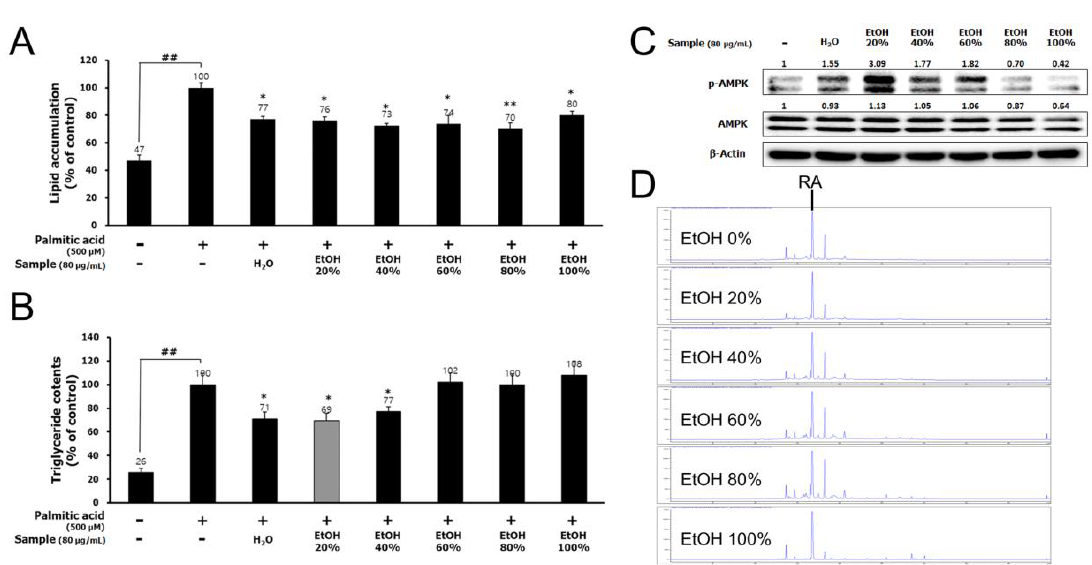
Figure 1. Effects of lemon balm extracts (0%, 20%, 40%, 60%, 80%, or 100% EtOH) on ( A ) lipid accumulation by Oil red-O staining and ( B ) triglyceride (TG) contents in palmitic acid (PA)-treated HepG2 cells. Effects of lemon balm extracts on ( C ) phosphorylation of AMP-activated protein kinase (AMPK) in HepG2 cells. ( D ) The rosmarinic acid (RA) content in the lemon balm extracts by liquid chromatograph. Results are expressed as the mean ± SD of three independent experiments. ## p < 0.01 compared with the control group; * p < 0.05 and ** p < 0.01 compared with the PA-treated cells.